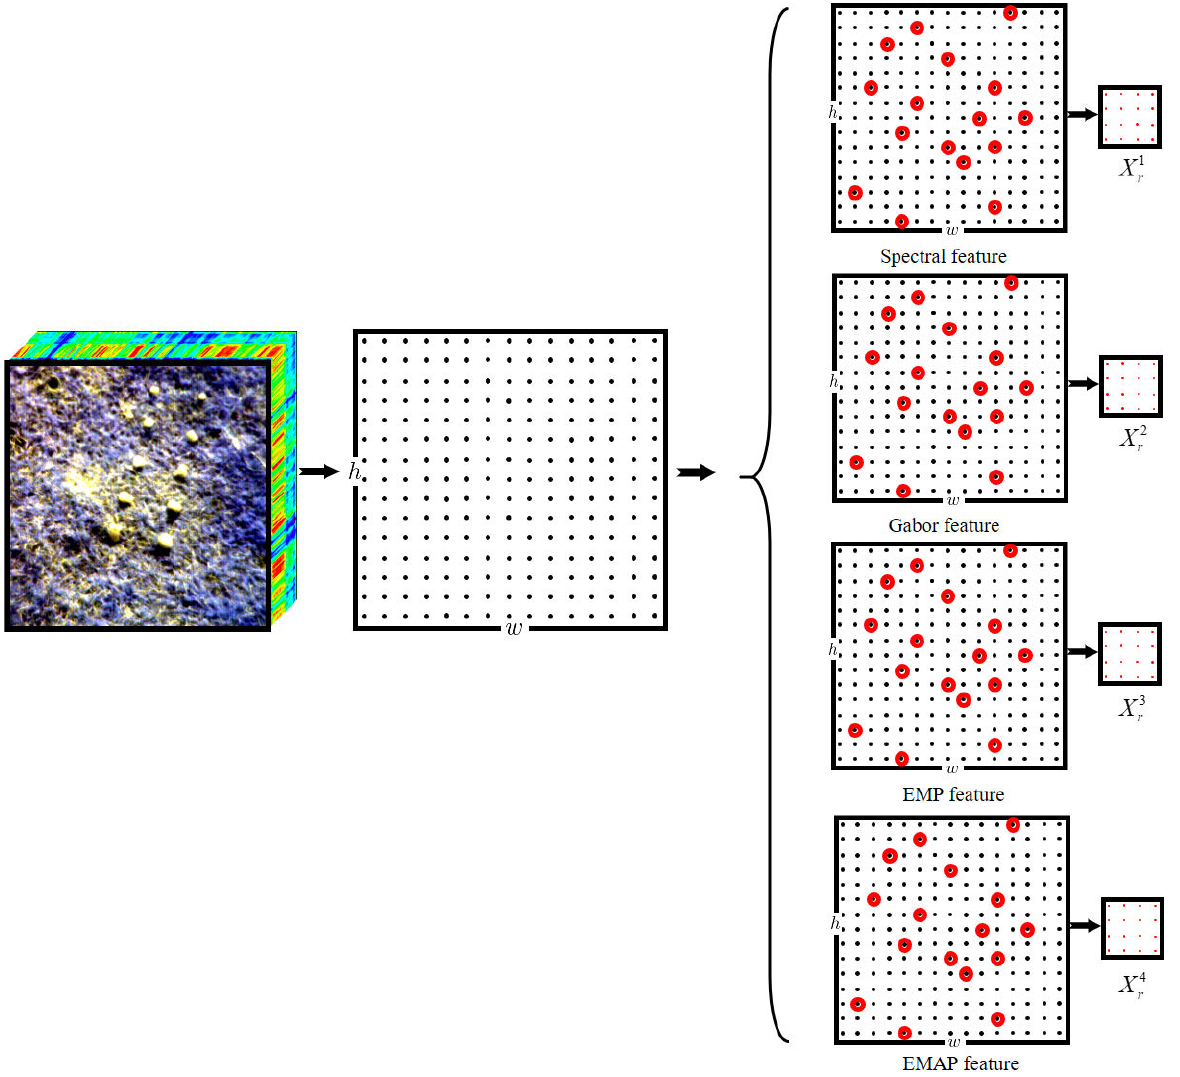
Figure 3. Feature extracting and random background modeling of the Random Collective Representation-Based Detector with Multiple Feature